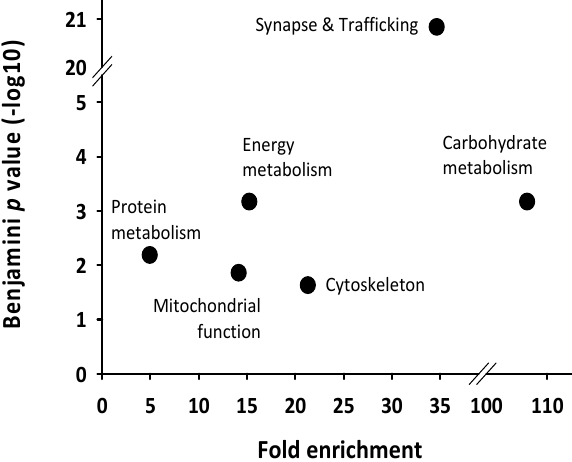
Figure 1. Functional annotation analysis from the set of rhythmically expressed proteins according to cosinor regression. The broad functions affected over the circadian day in the mice cerebellum were highlighted by setting thresholds for the fold enrichment (>2) and statistical analysis (Ease score < 0.1 and Benjamini p value < 0.05) that were computed using the scripts contained in the desktop version of DAVID (Ease v2.1).